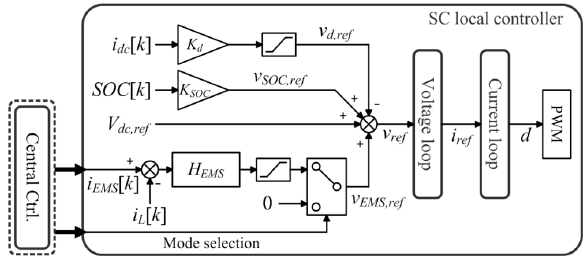
Figure 8. Control diagram of SC local controller.